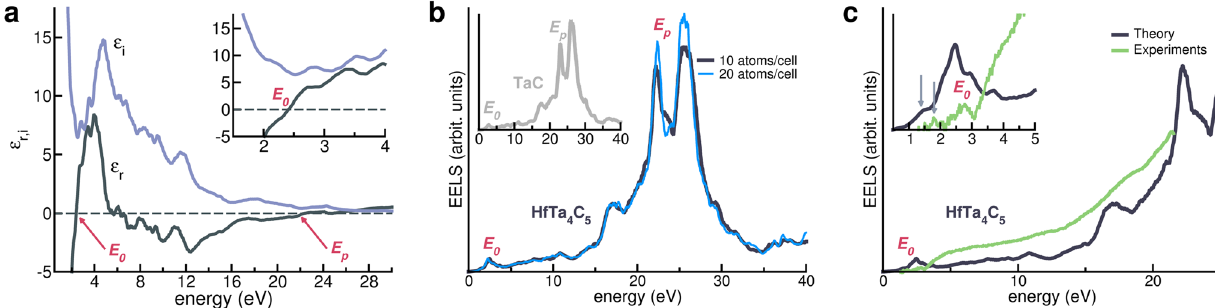
Fig. 1 | Optical properties of plasmonic HfTa 4 C 5 . a Real ( ϵ r , dark gray) and ima- ginary ( ϵ i , light purple) part of the complex dielectric function. E 0 and E p indicate the crossover energy and the plasmon energy, respectively. Inset zooms on low- energy range of the spectrum. b Simulated electron-energy loss spectrum (EELS) calculated by assuming two sets of structures with 10 (black) or 20 (cyan) atoms